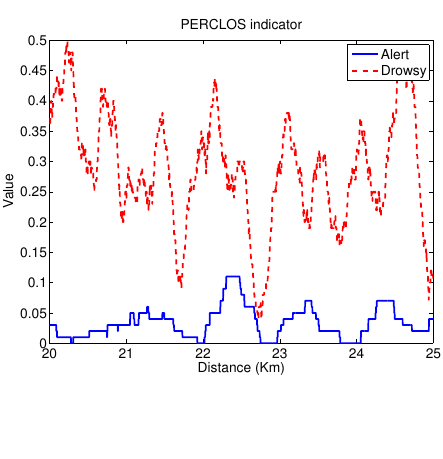
Figure 3. Temporal serie for P ERCLOS